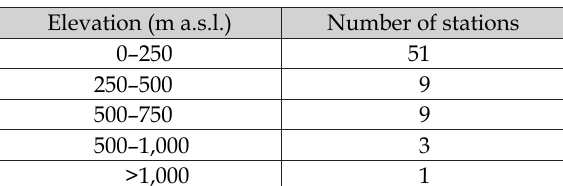
Table 1. Number of weather stations based on the